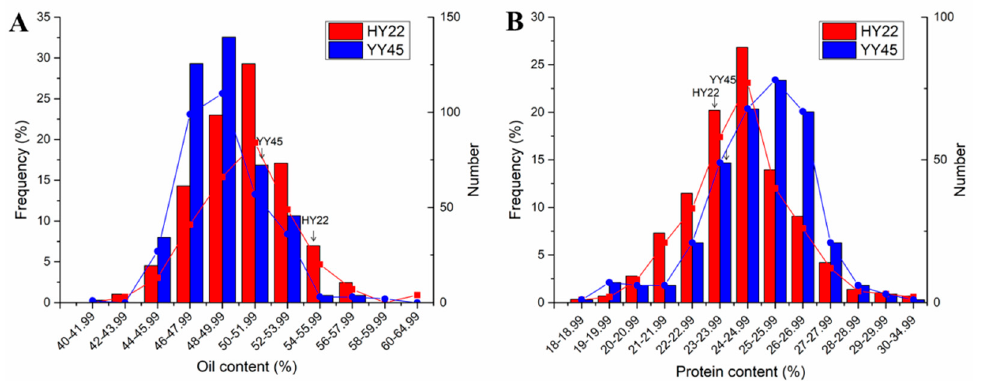
Figure 5. Frequency distribution of seed quality of M2 generation of HY22 and YY45 induced by EMS treatments. ( A ) Oil content; ( B ) Protein content.